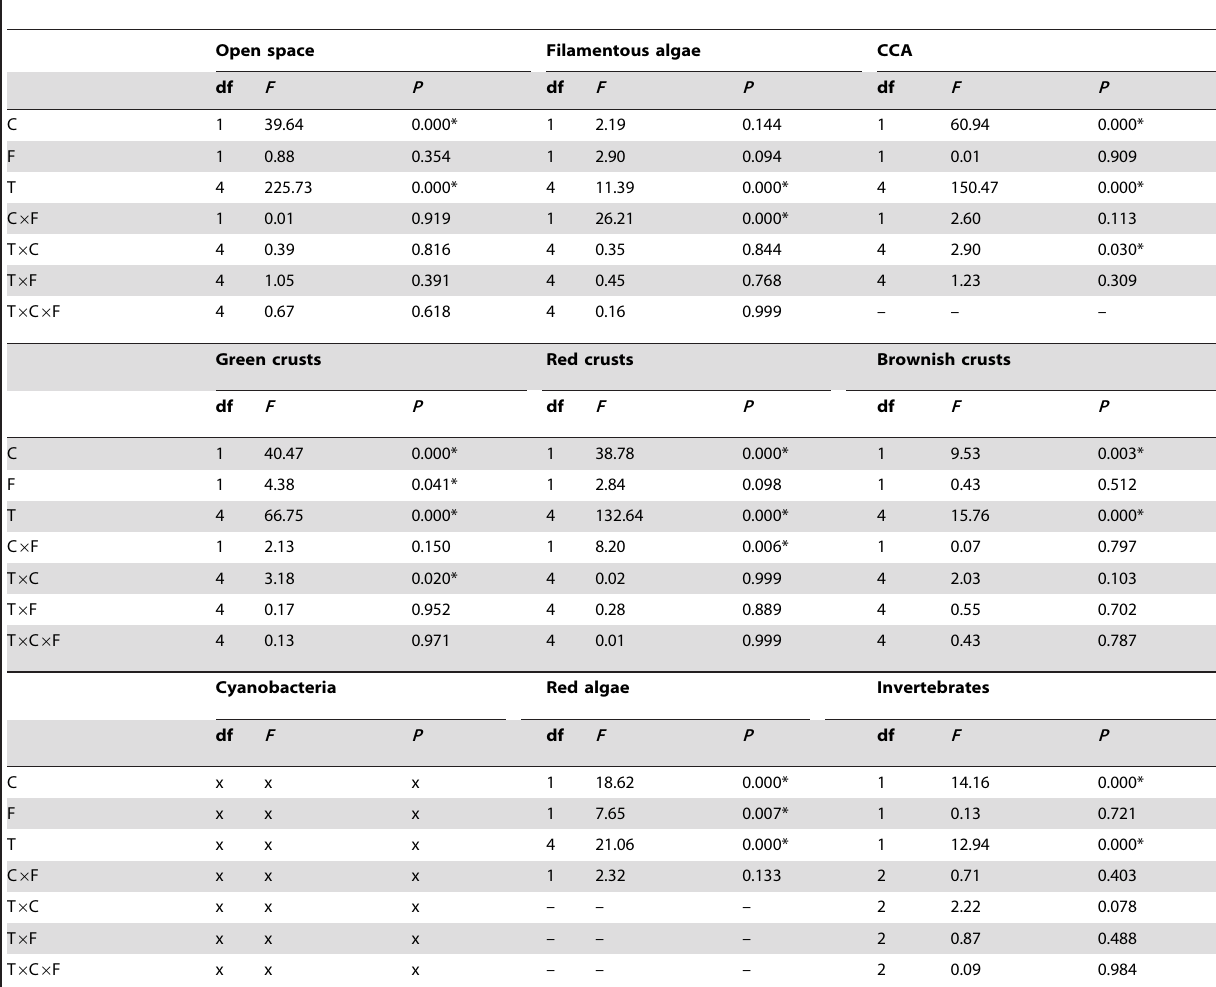
Table 4. Results of 3-factorial generalized linear model (GLM; binomial distribution and logit function) of functional algal groups of light shaded